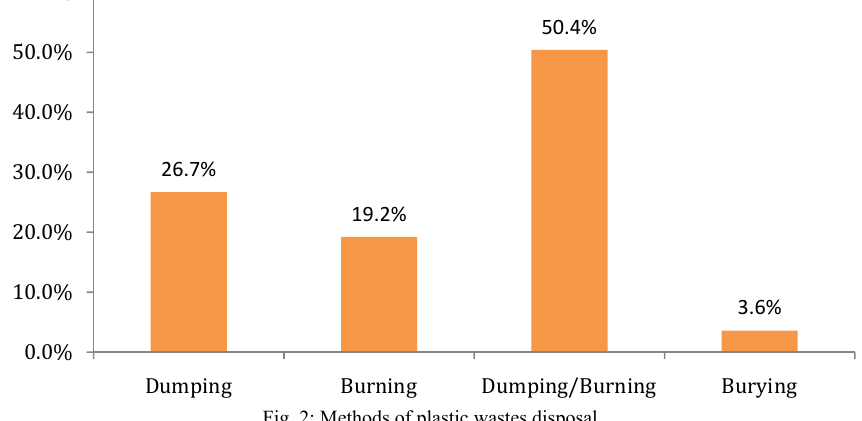
Fig. 2: Methods of plastic wastes disposal Burying